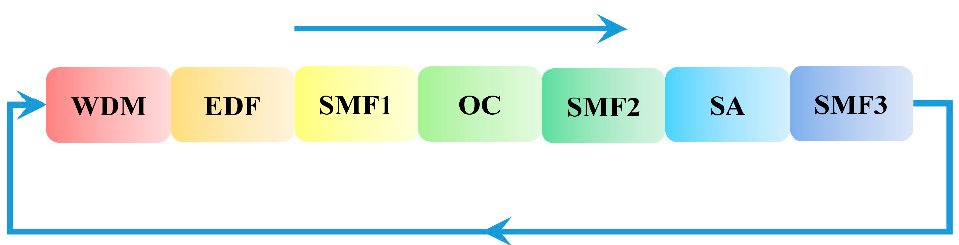
Figure 8. Simplified numerical simulation model.